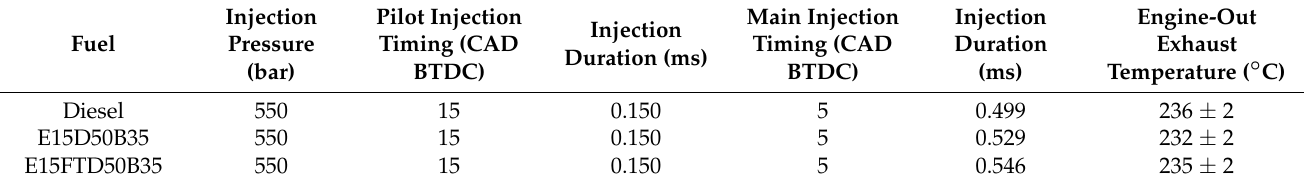
Table 3. Fuel injection parameters and exhaust